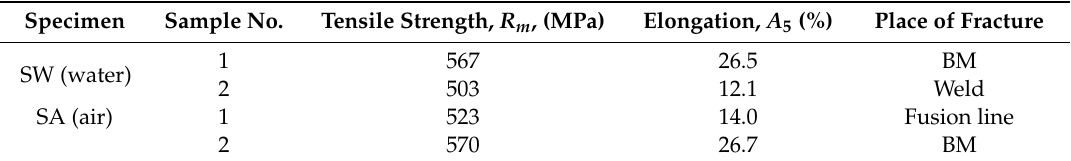
Table 4. Mechanical properties of the used materials following the manufacturer’s data.